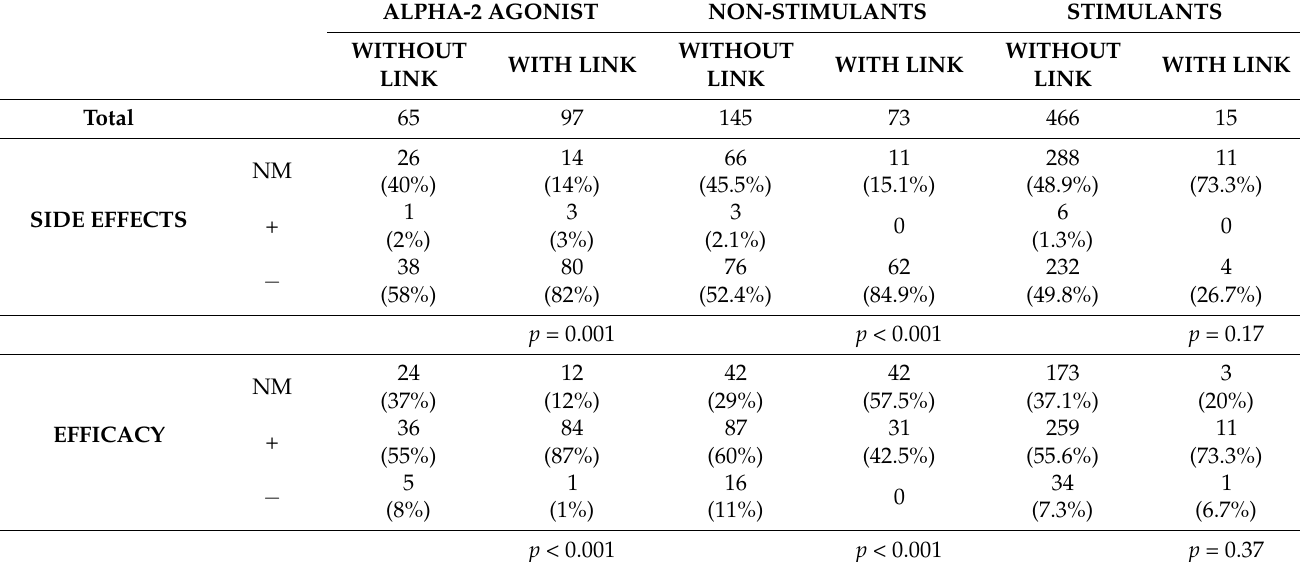
Table 4. Use of links in the different content categories of the tweets related to the three different groups of pharmacological